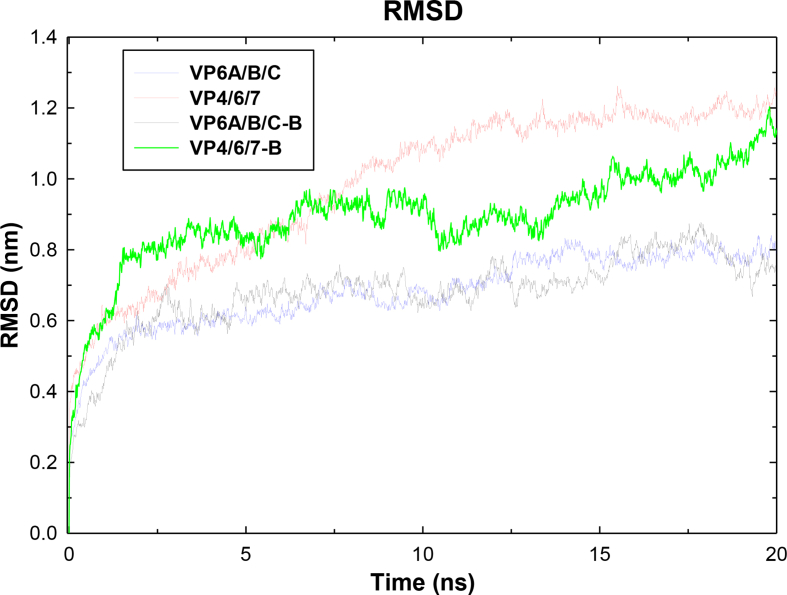
Tertiary structure modeling and structure validation of multi-epitope constructs. Cyan color represents CTL epitopes, orange represents HTL epitopes, blue represents linear B- cell epitopes and conformational B-cell epitope is highlighted with green. A. Construct 1; B. Construct 2; C. Construct 3; D. Construct 4; E. Construct 5; F. Construct 6; G. Construct 7; H. Construct 8; I. Construct 9; and J. Construct 10.